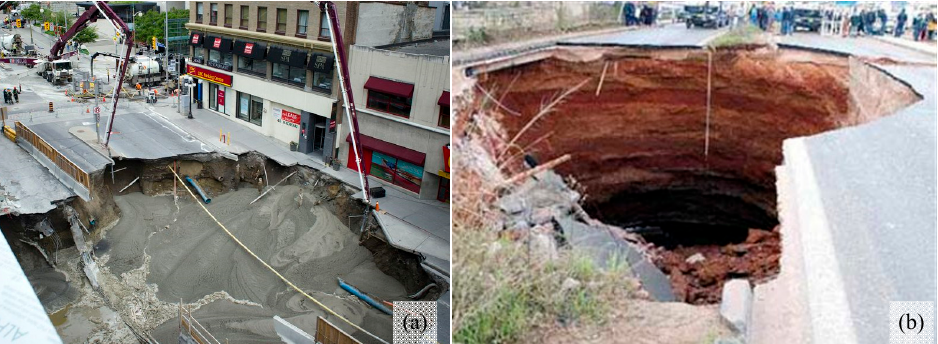
Figure 3. The problem of confidentiality in tunnel excavation data: ( a ) A sinkhole 8 m wide and 12 m deep opened up at the construction site of Ottawa’s light rail tunnel in 2016 [18]. ( b ) A 10 m wide and 15 m deep sinkhole opened up during tunneling beneath Doukissis Plakentias Ave., Athens for the Metro Line 3 in 2003 [19]. In both cases poor ground conditions have been reported but no other technical information is available.